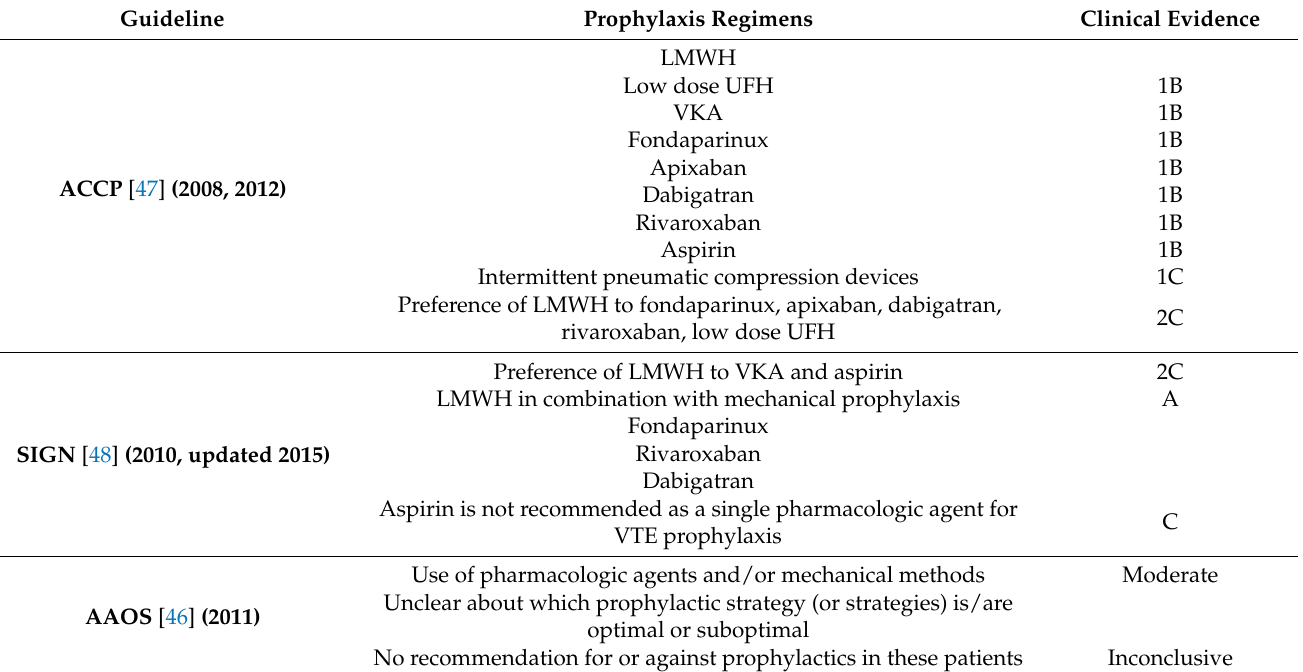
Table 4. Prophylaxis in Orthopaedic Surgery Patients.